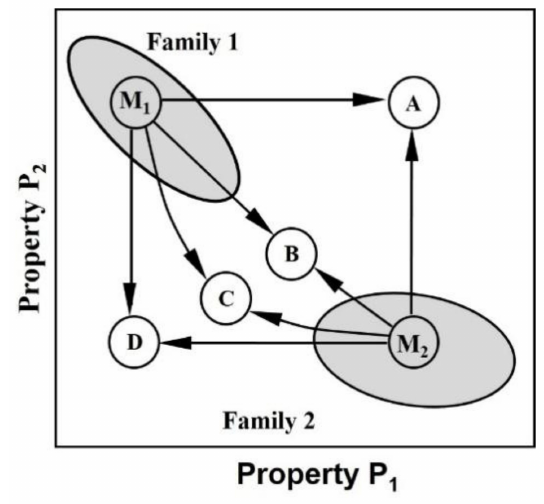
Figure 14. Possibilities of mixing